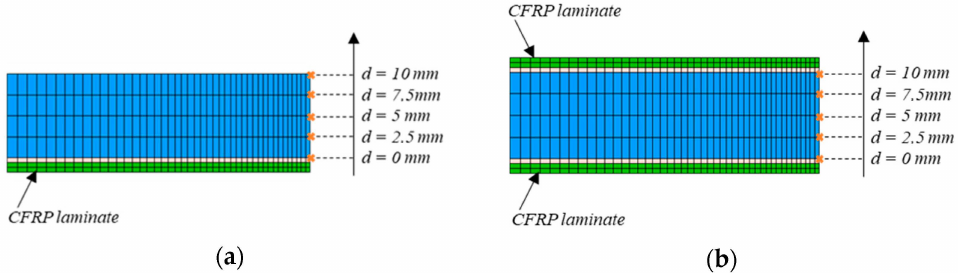
Figure 10. Measuring points through thickness of the steel plate used for SIF analysis with FEM: ( a ) single-sided repair specimen; ( b ) double-sided repair specimen.